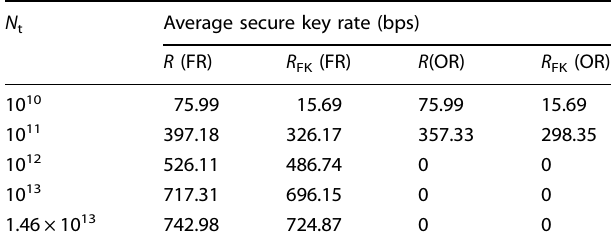
FR free-running RFI scheme, OR original RFI